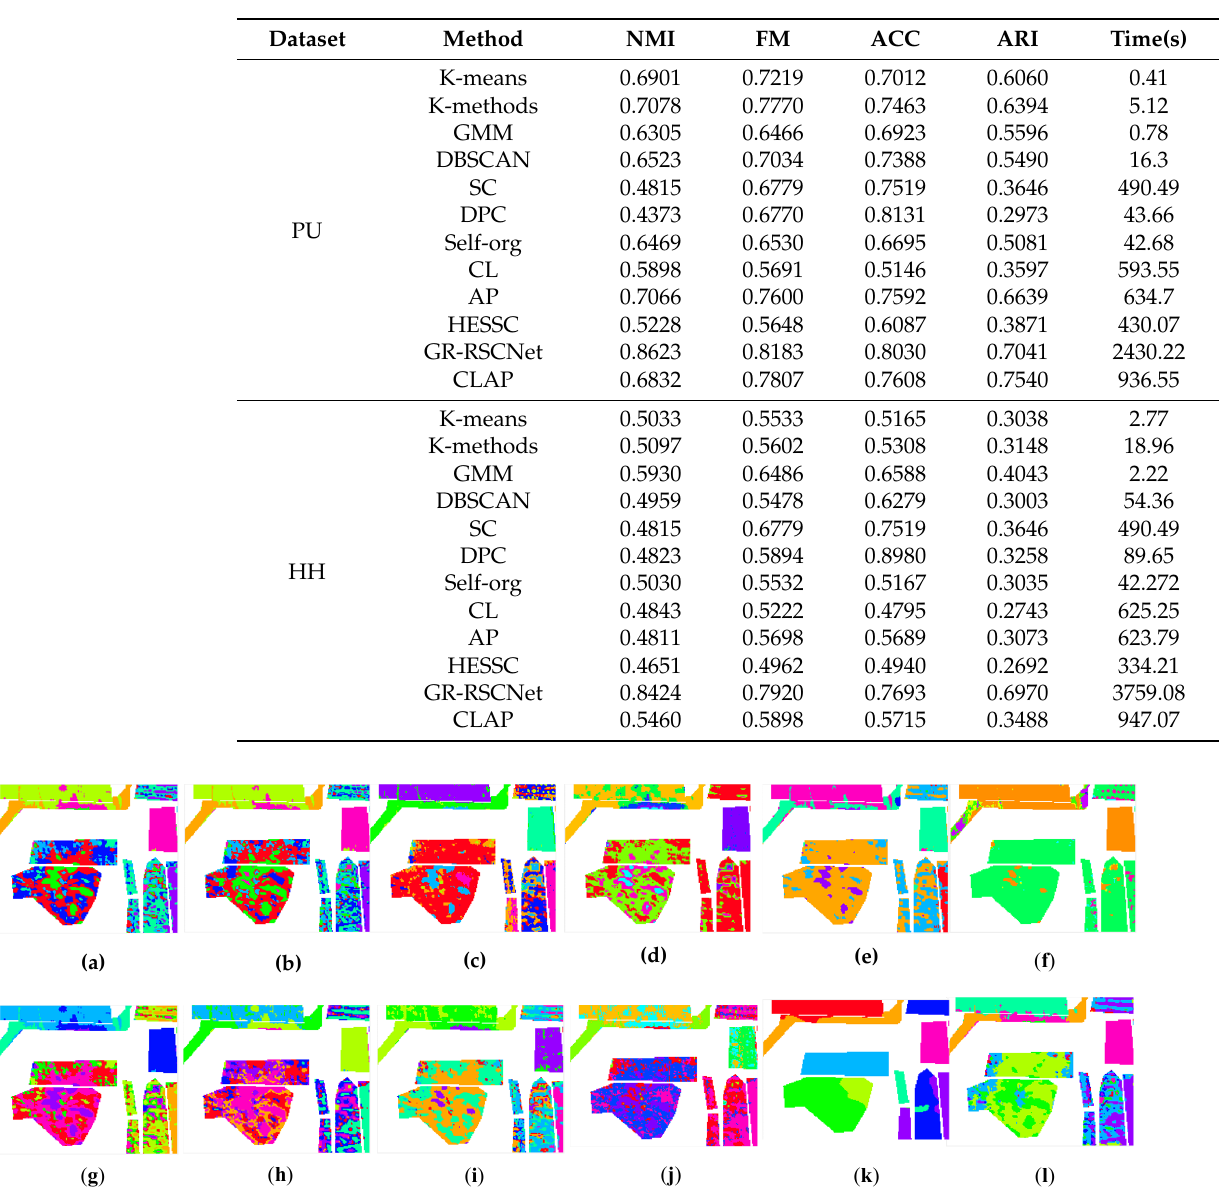
Figure 7. The unsupervised clustering maps of the WHU-Hi-HongHu dataset. ( a ) K-means. ( b ) K-methods. ( c ) GMM. ( d ) DBSCAN. ( e ) SC. ( f ) DPC. ( g ) Self-org. ( h ) CL. ( i ) AP. ( j ) HESSC. ( k ) GR-RSCNet. ( l )